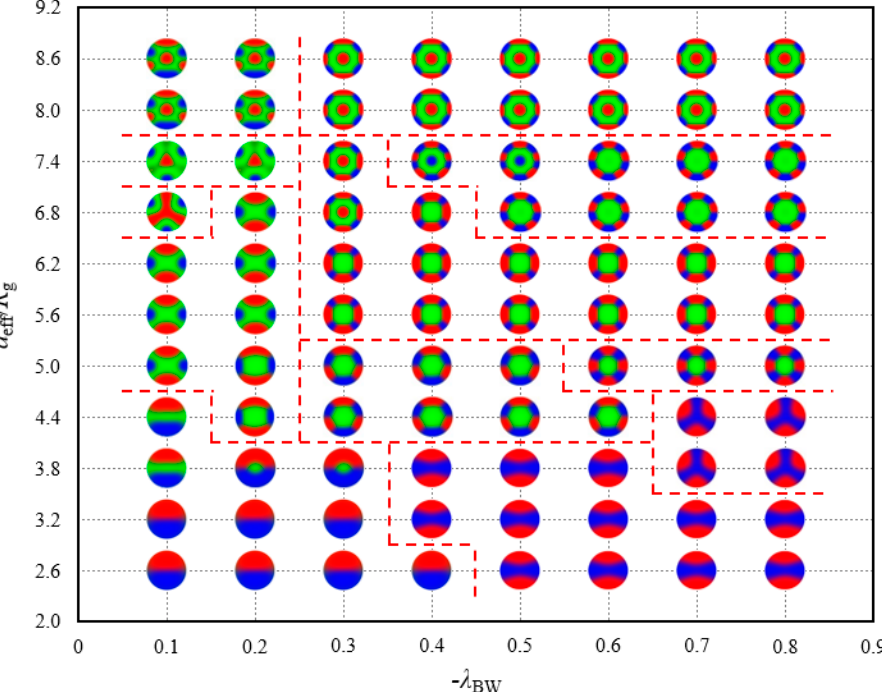
Figure 8. Phase diagram of the structures depicted in Figure 7. The phase diagram is constructed by effective diameters, d eff and B-attractive intensity, − λ BW . The red dashed lines are edge guides for the phase boundaries.